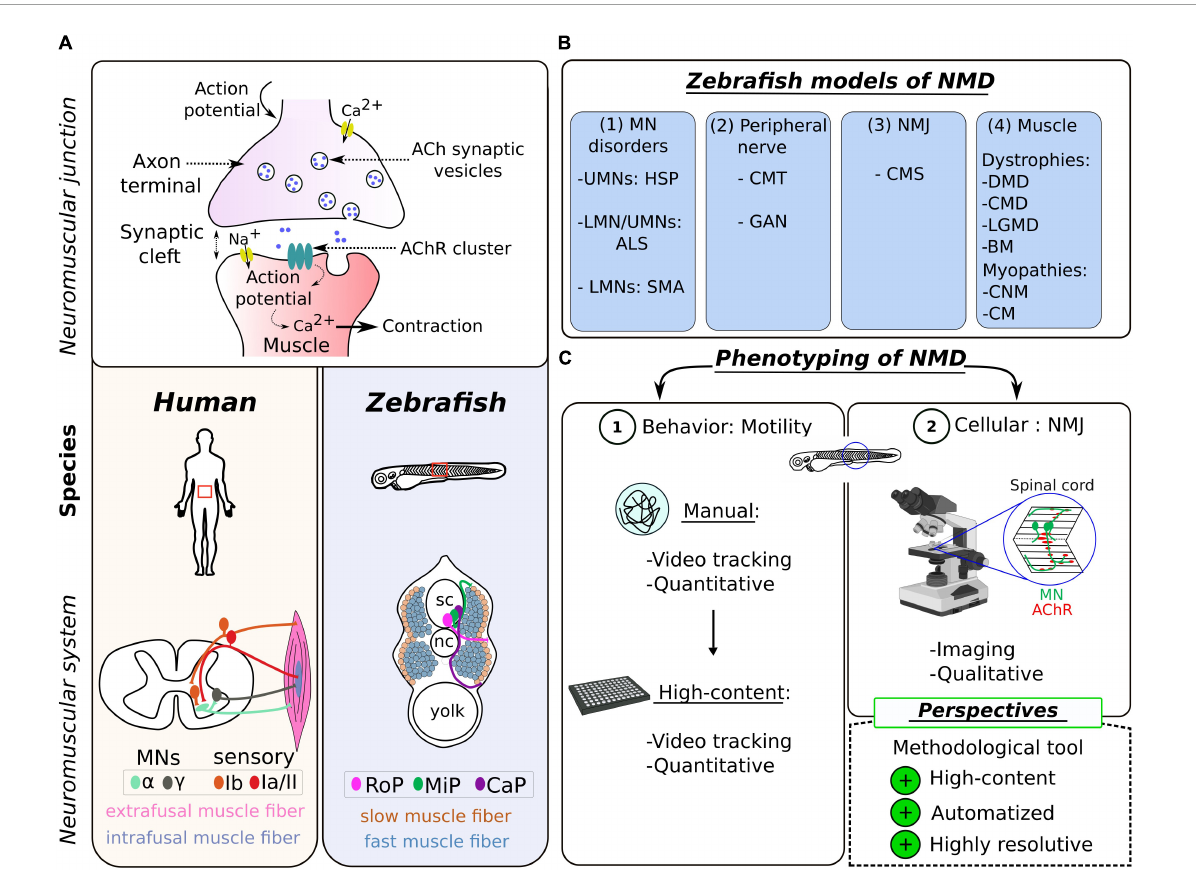
FIGURE1 Zebrafish as a model of choice to study the neuromuscular system in human. (A) Schematic representation of the neuromuscular synapse (top) and the topographical differences (bottom) between the zebrafish and the human species. (B) Table summarizing the different NMD pathologies modeled in zebrafish, categorized into four groups according to the first disease target (see Table 1 for details). UMN, upper motor neuron; LMN, lower motor neuron; HSP, hereditary spastic paraplegia; ALS, amyotrophic lateral sclerosis; SMA, spinal muscular atrophy; CMT, Charcot–Marie–Tooth; GAN, giant axonal neuropathy; NMJ, neuromuscular junction; CMS, congenital myasthenic syndrome; DMD, Duchenne muscular dystrophy; CMD, congenital muscular dystrophy; LGMD, limb–girdle muscular dystrophy; BM, Bethlem myopathy; CNM, centronuclear myopathies; CM, congenital myopathy. (C) Scheme summarizing the common tools for NMD phenotyping in the zebrafish, divided into two levels of investigation: (1) the locomotion at the behavioral level and (2) the visualization of the NMJ at the cellular level; and highlighting the methodological challenge presented as perspectives in this